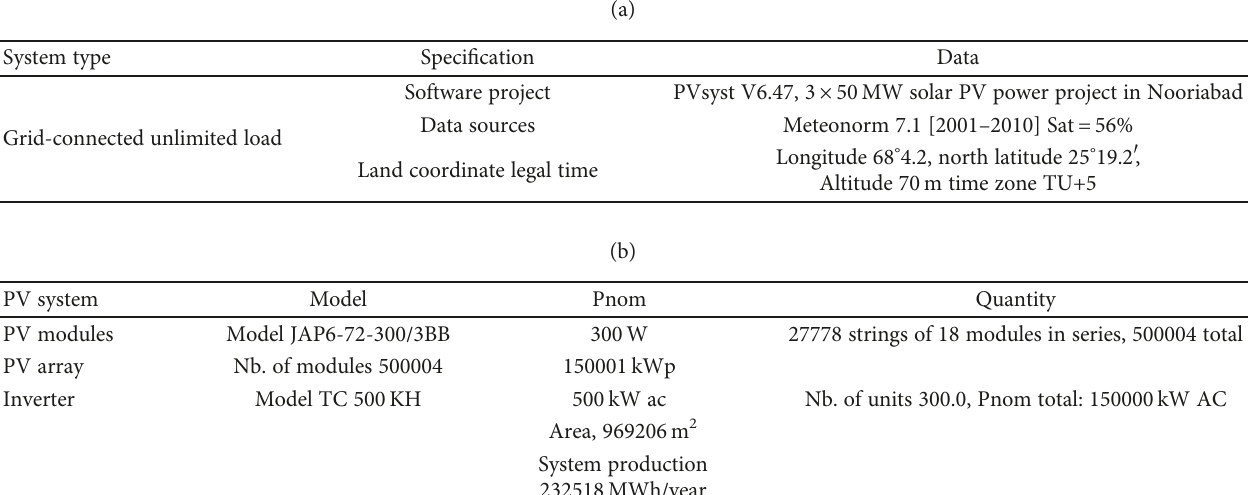
Table 7: Using 3 × 50 MW parameters for the simulations.